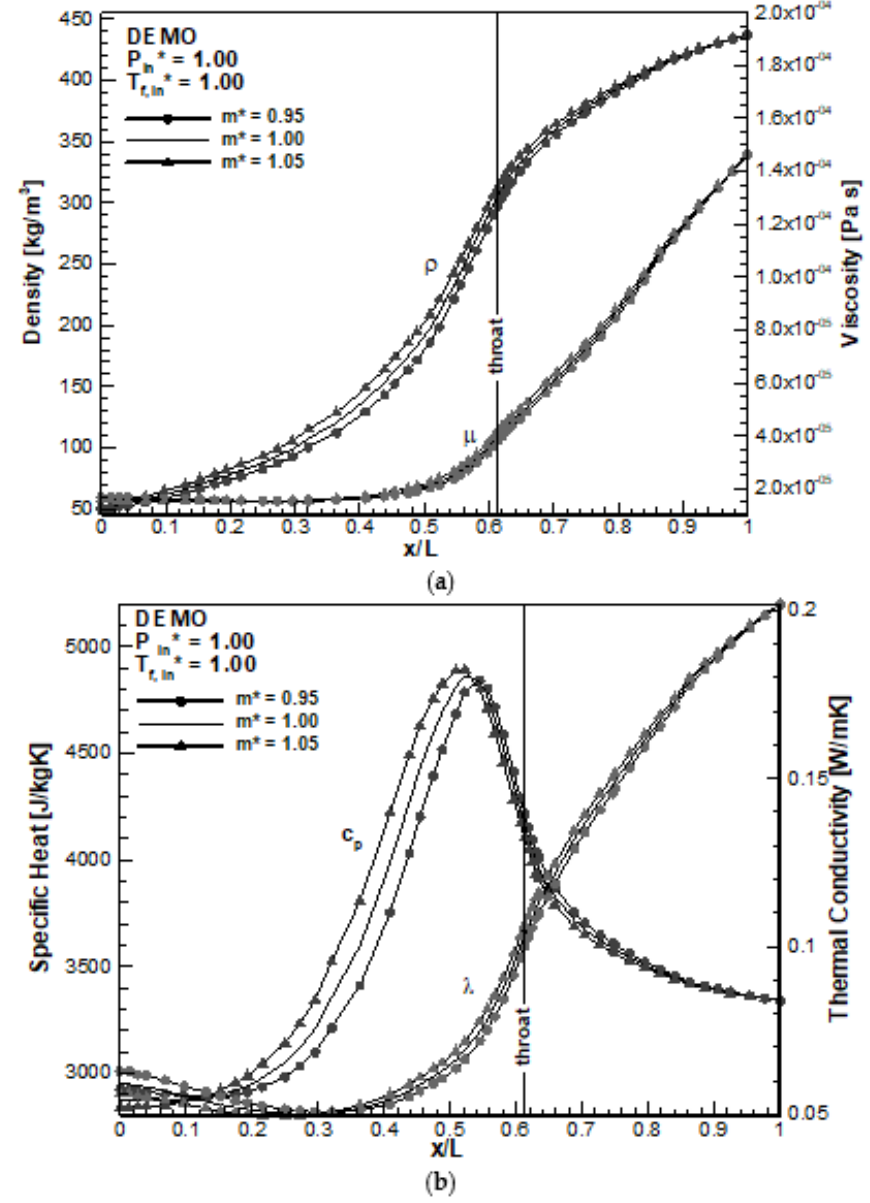
Figure 23. Axial profiles of thermophysical properties, considering the effects of mass-flow rate (runs 1, 7, 8): ( a ) density and viscosity; ( b ) specific heat and thermal conductivity.